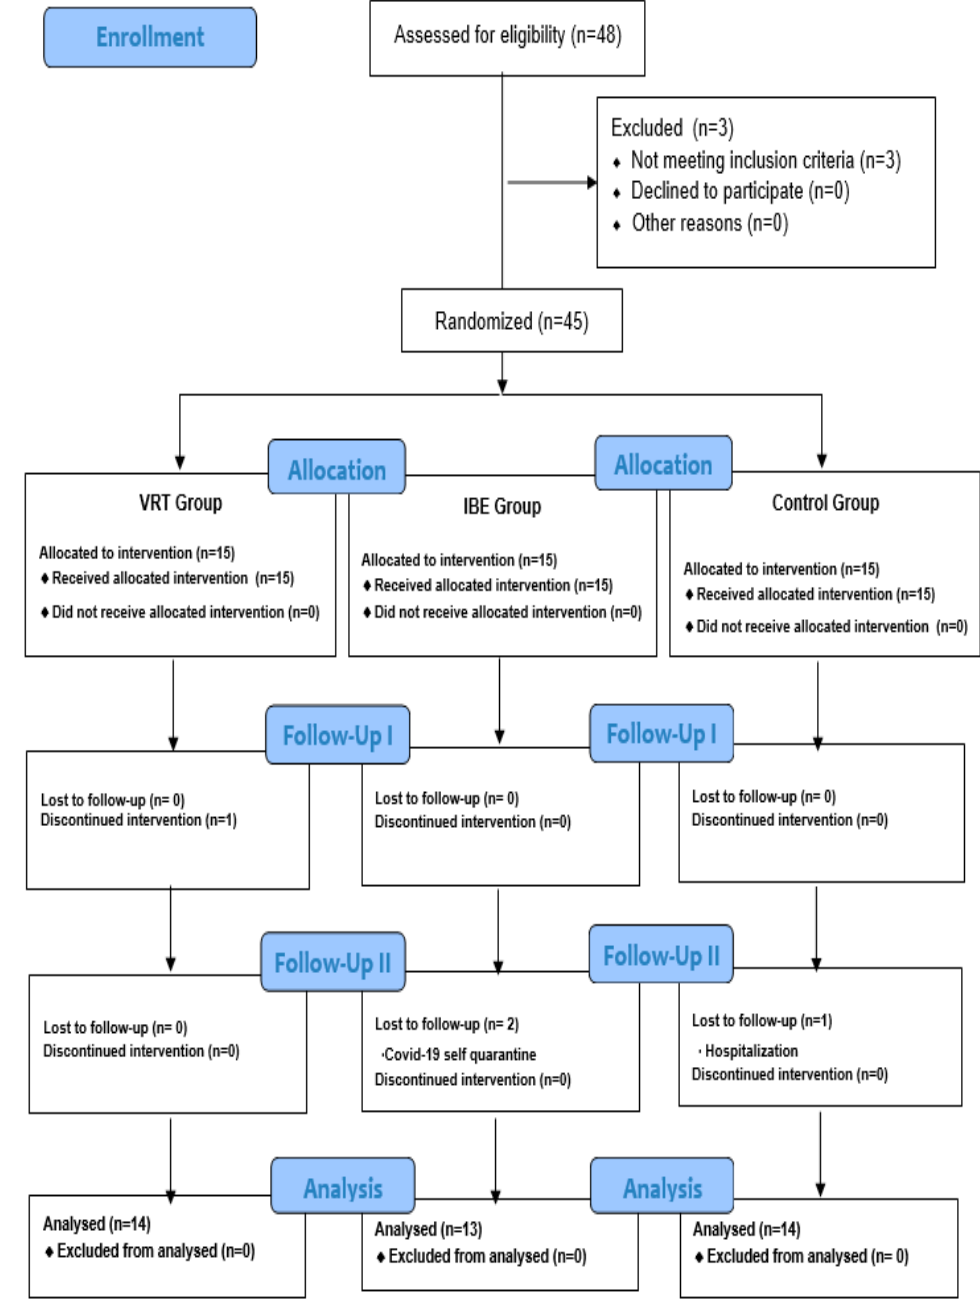
Figure 2. Flow diagram. VRT: Virtual reality therapy group; IBE: indoor bicycle exercise group; CG: control group.